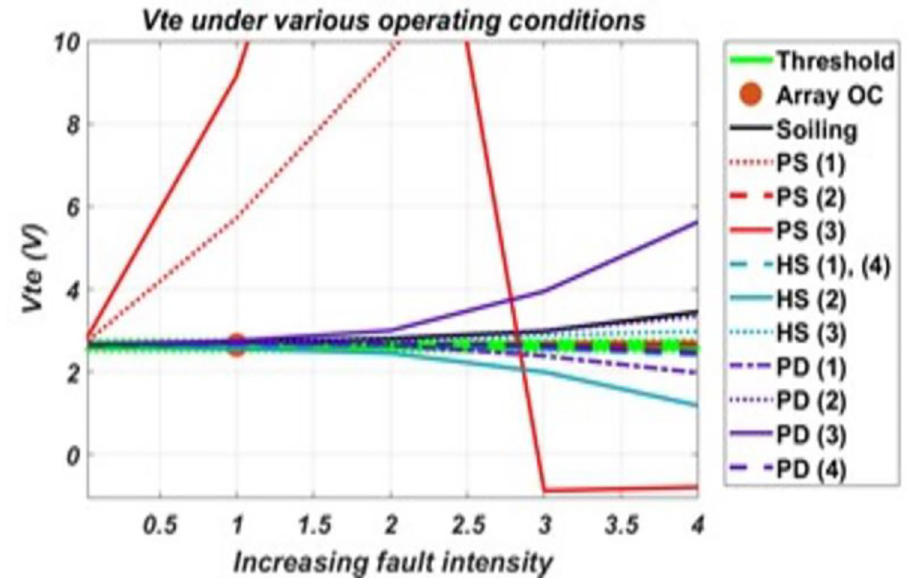
Fig 6. The response of Vte to various conditions and their varying intensity